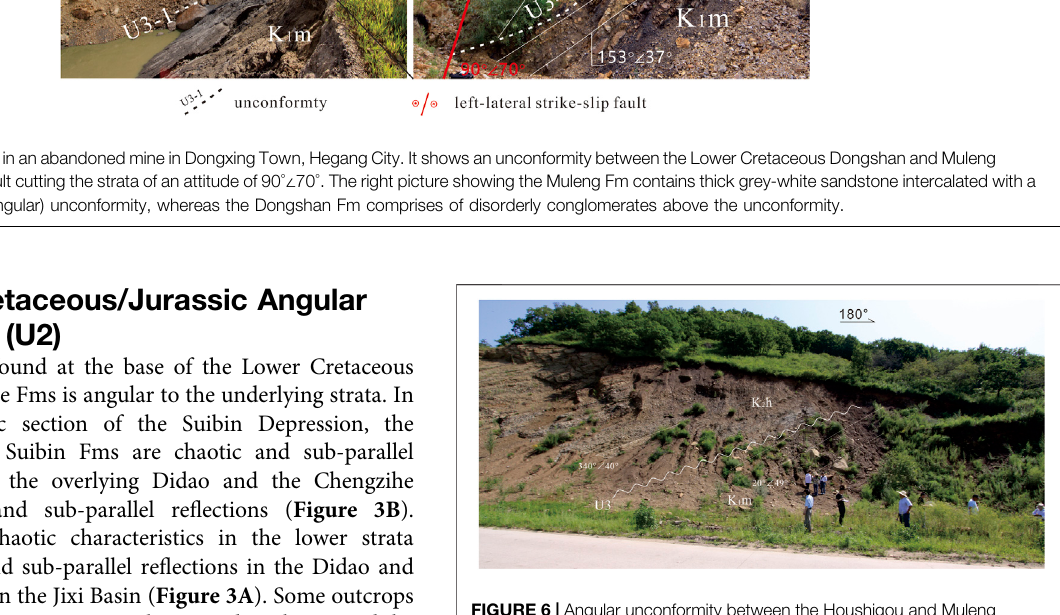
Frontiers in Earth Science |